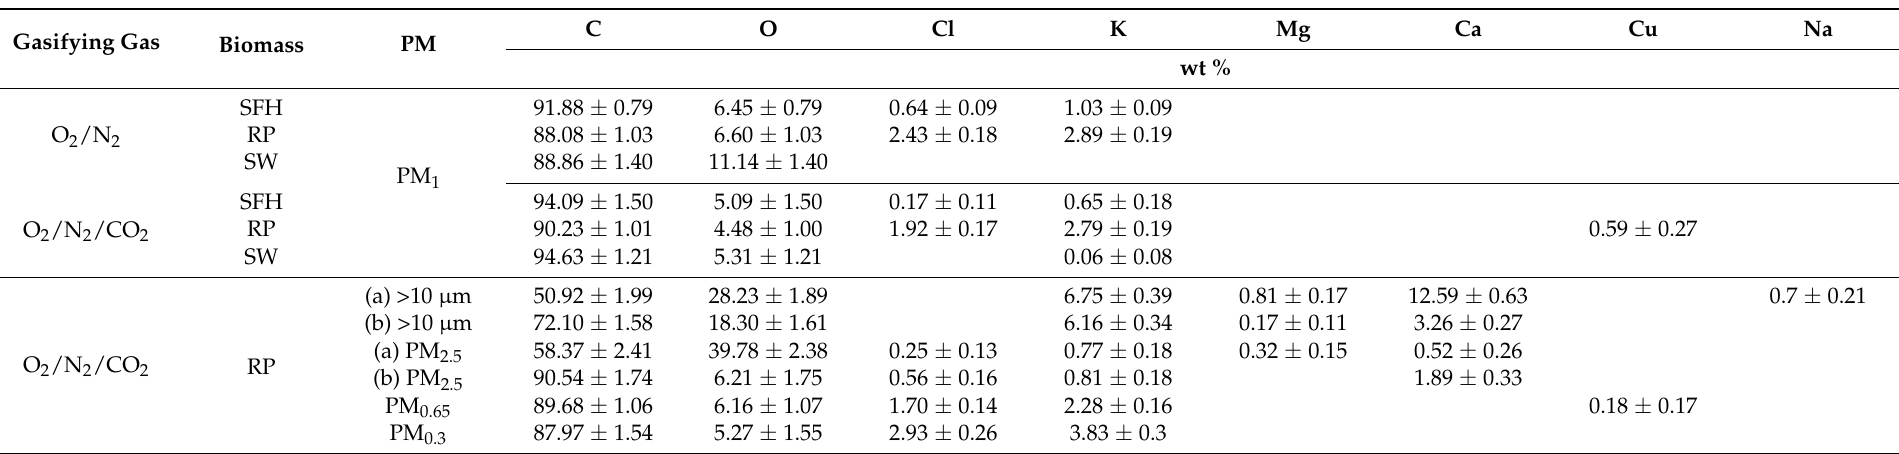
Table 3. Elemental composition of particulate matter, obtained through the EDS